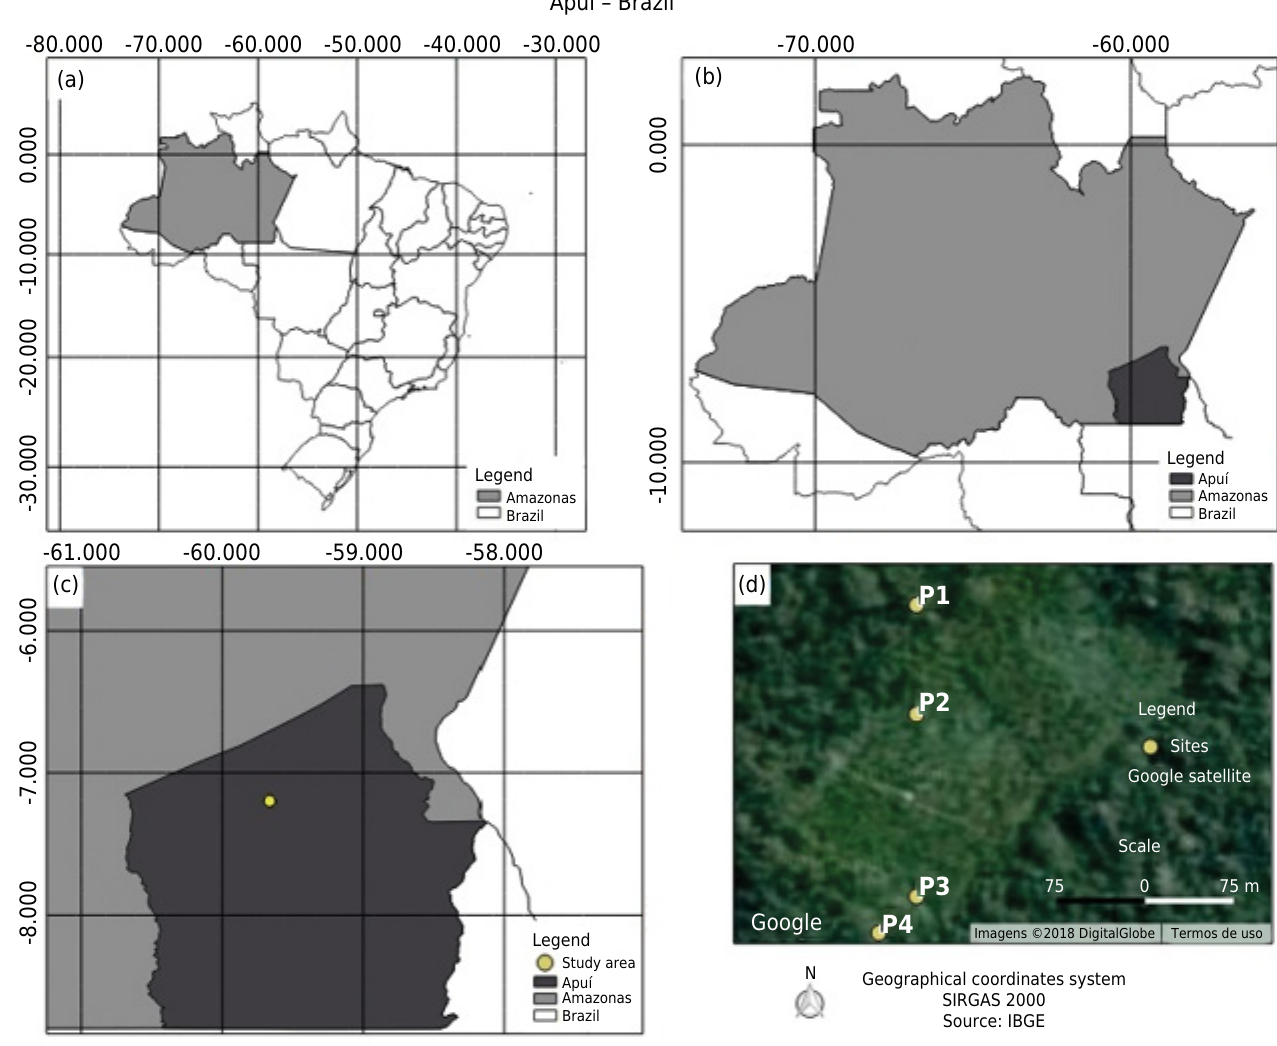
Figure 1. Location of the studied area in western Amazonia,